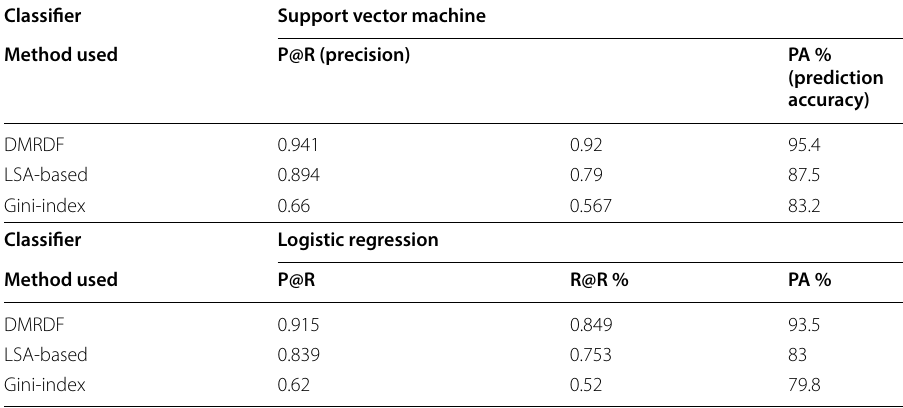
Table 3 Performance comparison of the proposed model with state of art